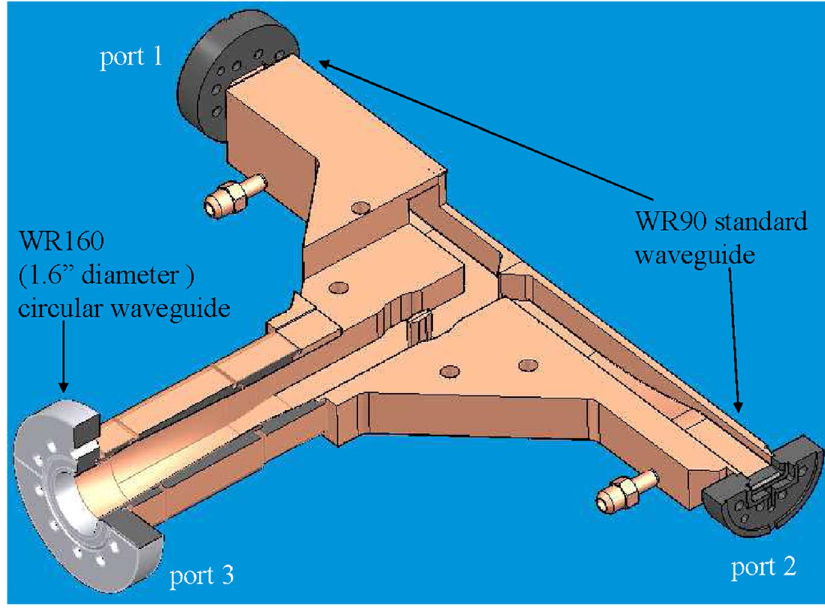
FIG. 7. (Color) Cutaway view of the mode launcher/combiner. Depending on the phases and amplitudes of the waves incident in the rectangular ports either or both of the TE